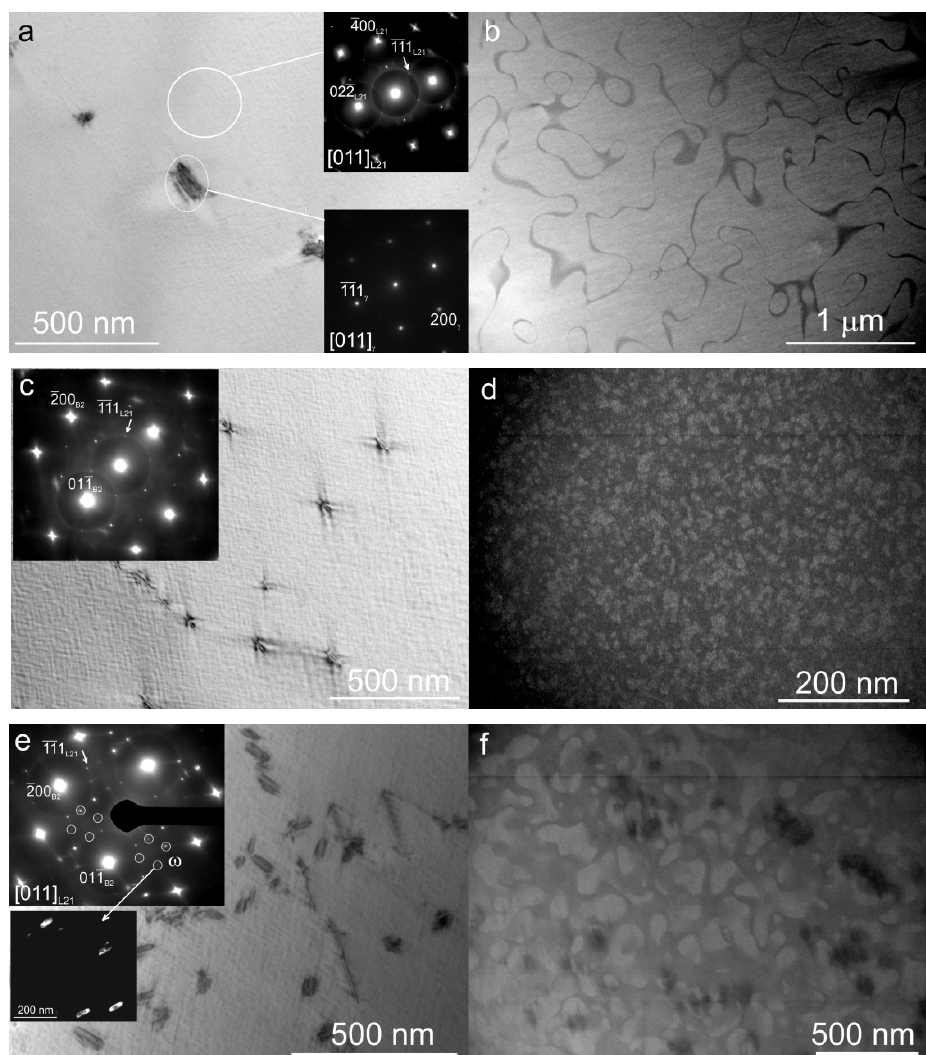
Figure 1. Microstructures of Ni 44 Fe 19 Ga 27 Co 10 single crystals: ( a , b )—as-grown crystals; ( c , d )— quenched crystals; ( e , f )—aged crystals; ( a , c , e )—bright-field images and SAEDPs with the [011] L21 zone axis of matrix; ( b , d , f )—dark-field images in the <111> L21 reflexes marked with the arrows in the SAEDPs. The dark-field images contain some bright areas, they are L2 1 -domains. In Figure ( a ) SAEDP is from the γ -phase particles, the zone axis is [011] γ ; in Figure ( e ): circles indicate the reflexes from the ω -phase, where a dark field was obtained.